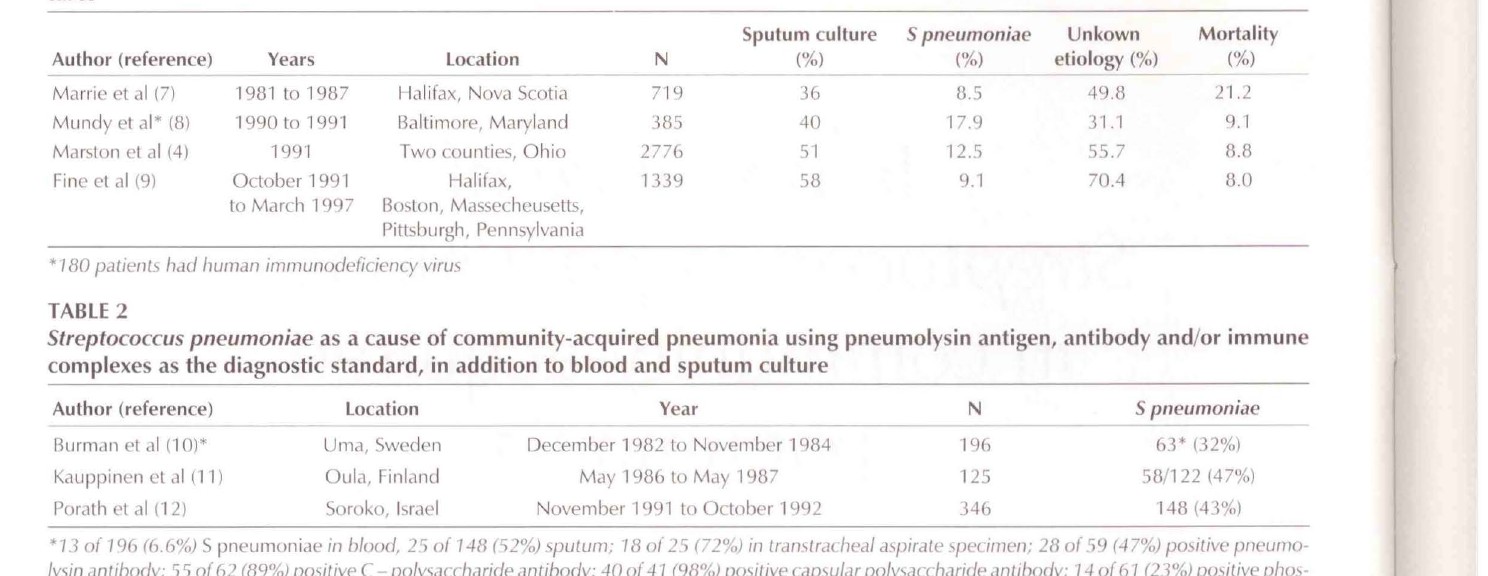
Frequency of Streptococcus pneumoniae as a cause of community-acquired pneumoniae as determined blood and sputum